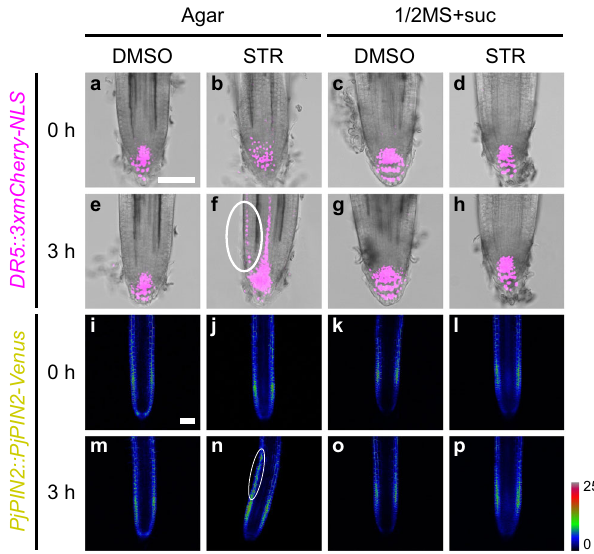
Fig. 3 | Expression dynamics of auxin-related genes upon SL treatment. Expression patterns of the DR5 ( a – h ) and PjPIN2 ( i – p )promotersdriving expression ofa fl uorescentmarkergeneupontreatmentwith1 µ M rac -strigol(STR)or0.1%(v/v) DMSO solutions. Filter paper disks were placed 5-mm to the left of the roots. Con- focal photos were taken at the indicated time points after treatment on media with (1/2MS+suc) or without (agar) nutrient. Bright- fi eld and fl uorescent images were merged in a – h . Venus fl uorescence intensity was represented in a Rainbow RGB spectrum in i – p using ImageJ 71 . White ovals indicate asymmetrical expression. The scalebarsin a and i alsoreferto b – h and j – p ,respectively.Bars=100 µ m.Atleastsix biological replicates were performed for each condition with similar